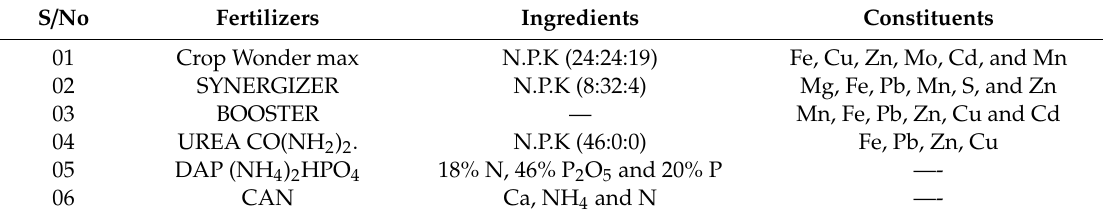
Table 4. Types of fertilizers used in a studied area from field survey from the farmers. S / No Fertilizers